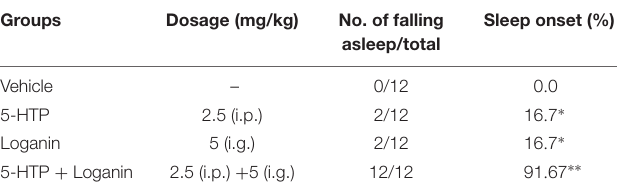
TABLE 2 | Effect of loganin combined with 5-HTP on sleep onset of mice treated with hypnotic dosage of pentobarbital (45 mg/kg, i.p.). Groups Dosage